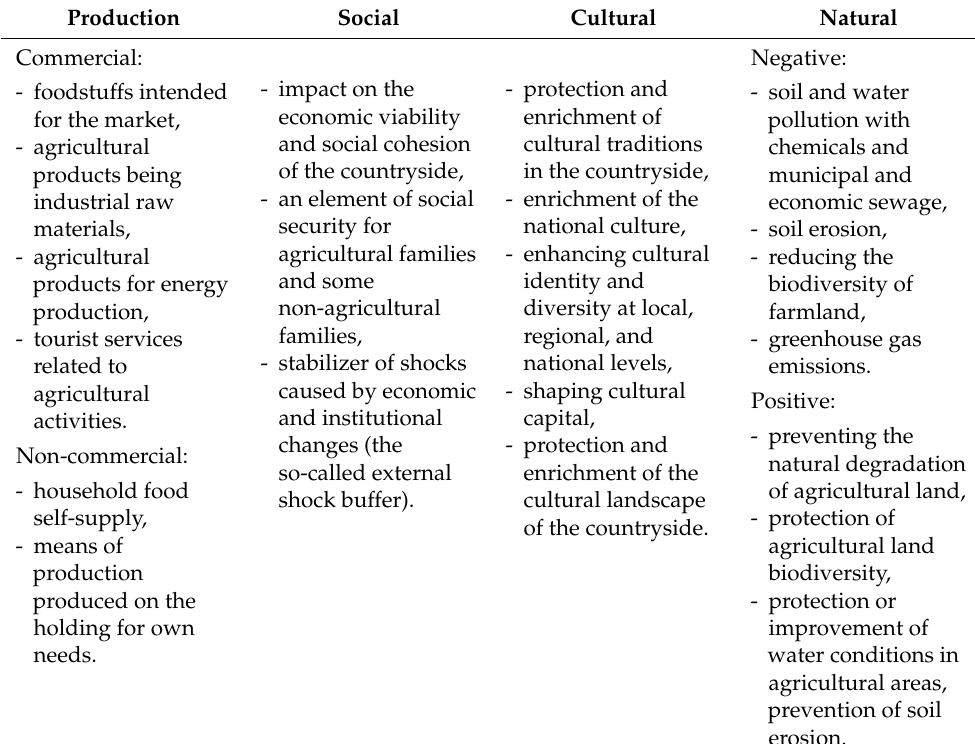
Table 1. Classification of market and non-market functions of agriculture.